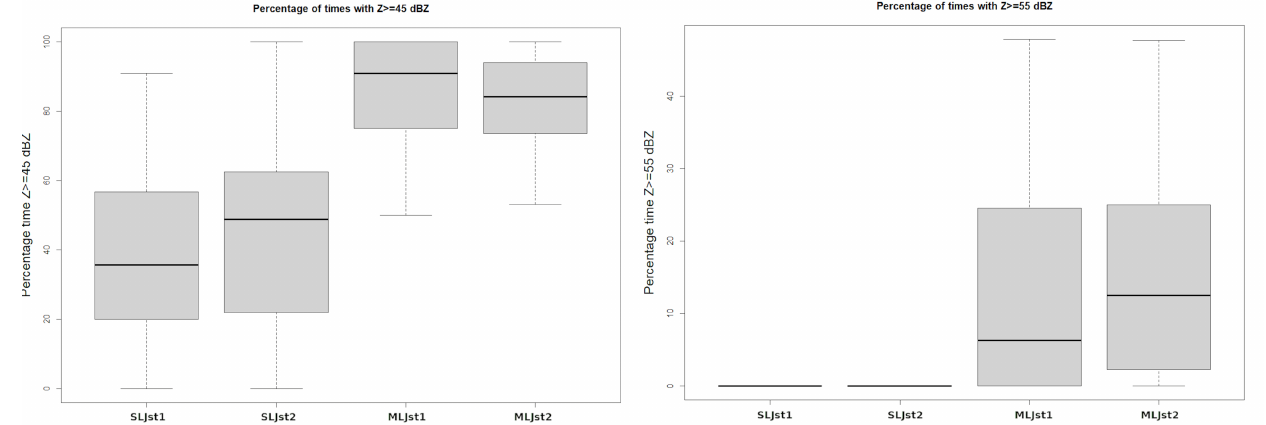
Figure 12. Same as Figure 10, but for the number of times that maximum reflectivity exceeded a certain threshold: ( left ) 45 dBZ; ( right ) 55 dBZ.